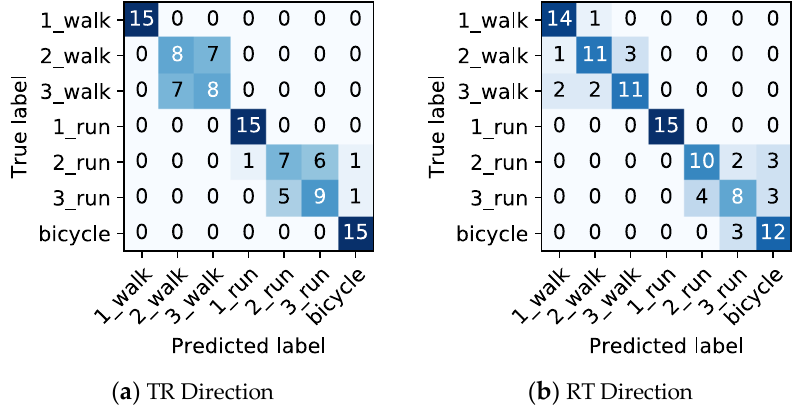
Figure 10. Confusion matrix for transmitter side to receiver side (TR) and receiver side to transmitter side (RT) directions when using only the lengths of the final passing section.